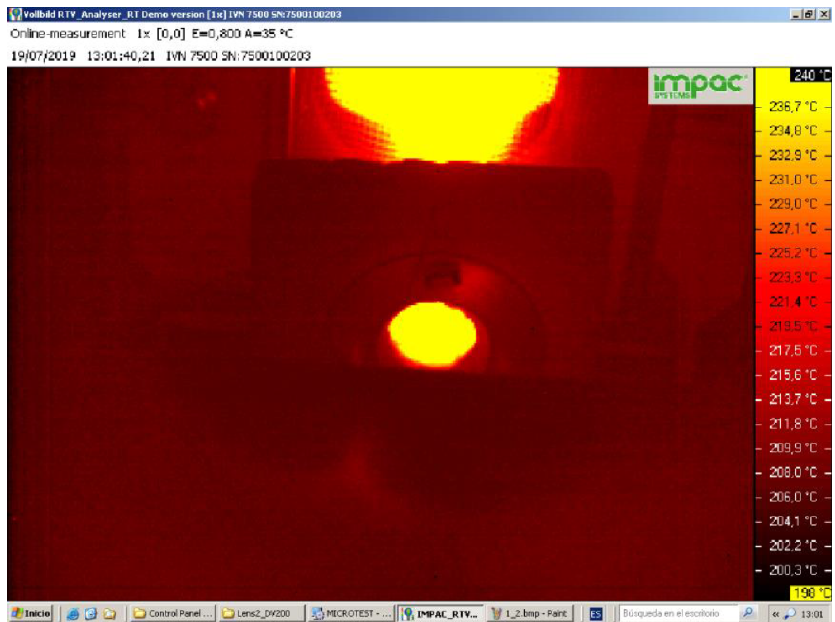
Figure 5. Details of experimental setup for the irradiation tests using xenon arc lamp projector. ( a ) Photo of an irradiation test showing a metallic grid used as radiation attenuator (at the left) and irradiated lens (at the right); ( b ) lens (of 76.2 mm diameter) being irradiated, simply surrounded by alumina foam; ( c ) for confining the radiation beam, in some tests we have used a mask made of alumina felt with a circular aperture of 1 inch (25.4 mm) diameter; the Gardon-type radiometer is on the right protected by alumina foam; ( d ) fractured lens (of 50.8 mm diameter) mounted in metallic holder.